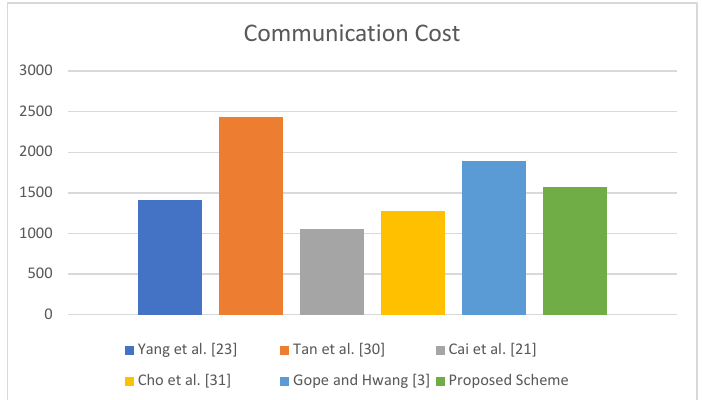
Figure 8. Communication